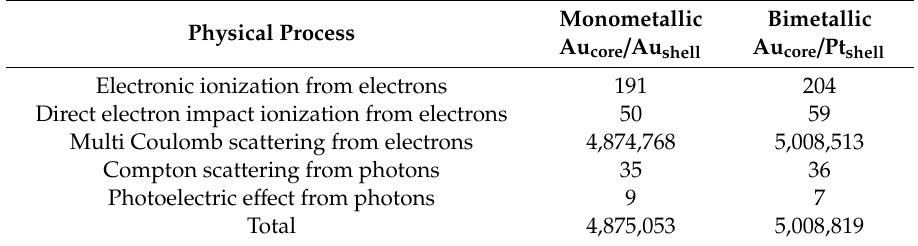
Table 4. Physical processes from the Geant4-Penelope model induced in mono- and bimetallic NPs activated by Cobalt-60 γ -rays and the corresponding electron secondary spectrum. The simulation steps of 3 × 10 8 were used to produce the output